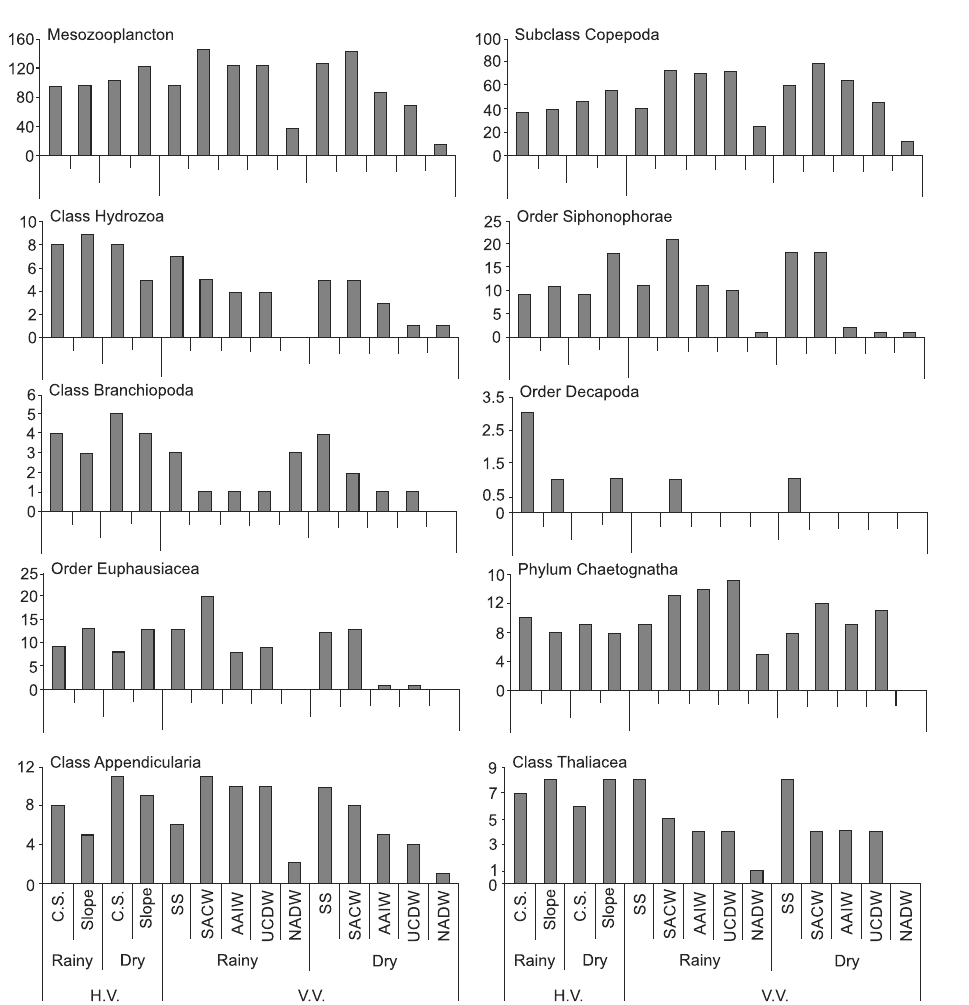
Figure 3. Horizontal distribution in the Subsurface Water, over the continental shelf and slope, and vertical distribution over the slope of species richness of each mesozooplankton group in the Campos Basin, central Brazilian coast, during the rainy and dry seasons. C.S. – Continental shelf, SS – Subsurface Water, SACW – South Atlantic Central Water, AAIW – Antarctic Intermediate Water, UCDW – Upper Circumpolar Deep Water, NADW – North Atlantic Deep Water, H.V. – Horizontal variation, V.V. – Vertical